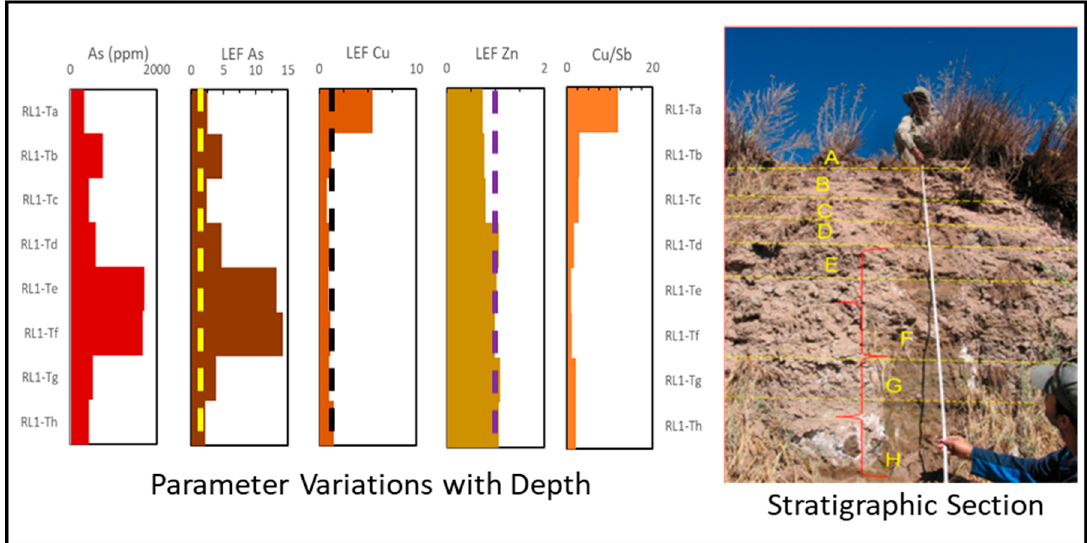
Figure 12. Vertical distribution of As concentration, selected LEF values, and Cu/Sb ratios for alluvial valley fill deposits located at RL1 (see Figure 1 for site location).